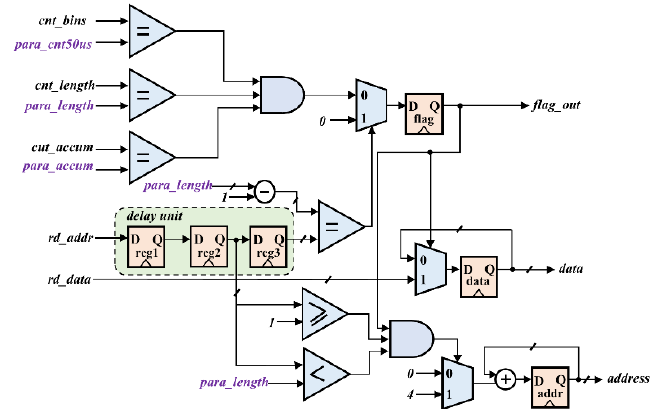
Figure 7. The logic structure diagram of the output module.